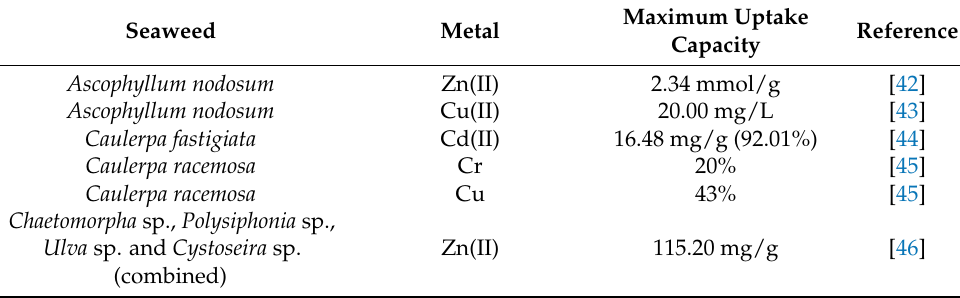
Table 3. Seaweed-based strategies for recovery of metallic